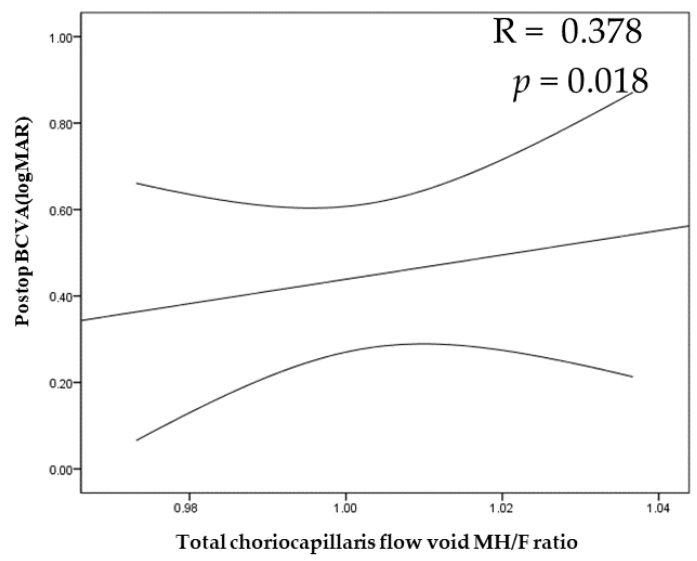
Figure 7. Correlation of postoperative BCVA with the EZ-RPE MH/F and total CC flow void MH/F ratios. The curved lines indicate a 95% confidence interval of the linear regression line. EZ-RPE MH/F ratio, ellipsoid zone to retinal pigment epithelium distance in the MH/unaffected eye; total CC flow void MH/F ratio, total choriocapillaris flow void of the MH/unaffected eye.